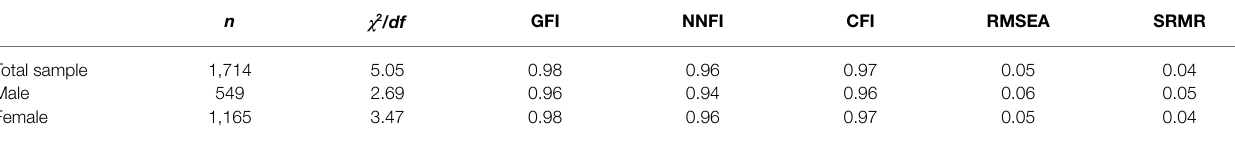
TABLE 3 | Model comparisons between genders (Sample 3, n = 1,714).